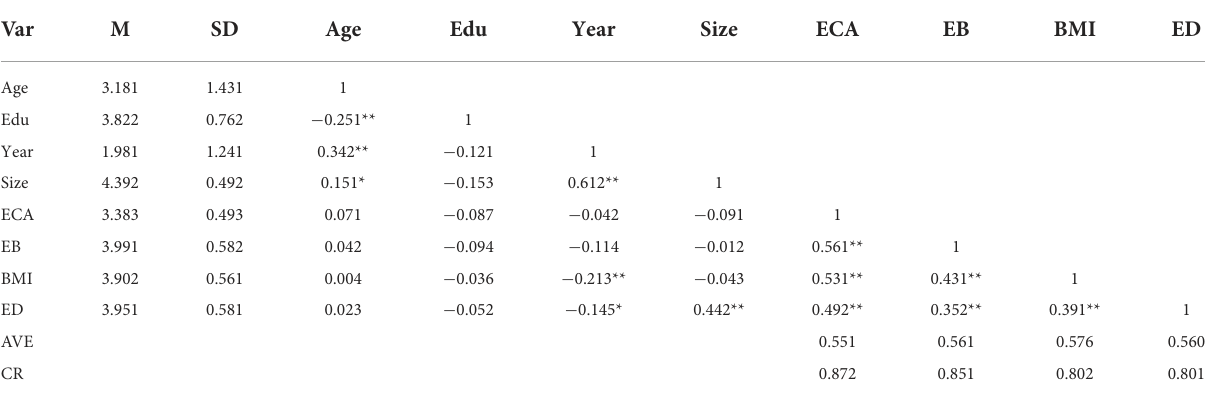
TABLE 2 Correlation and descriptive